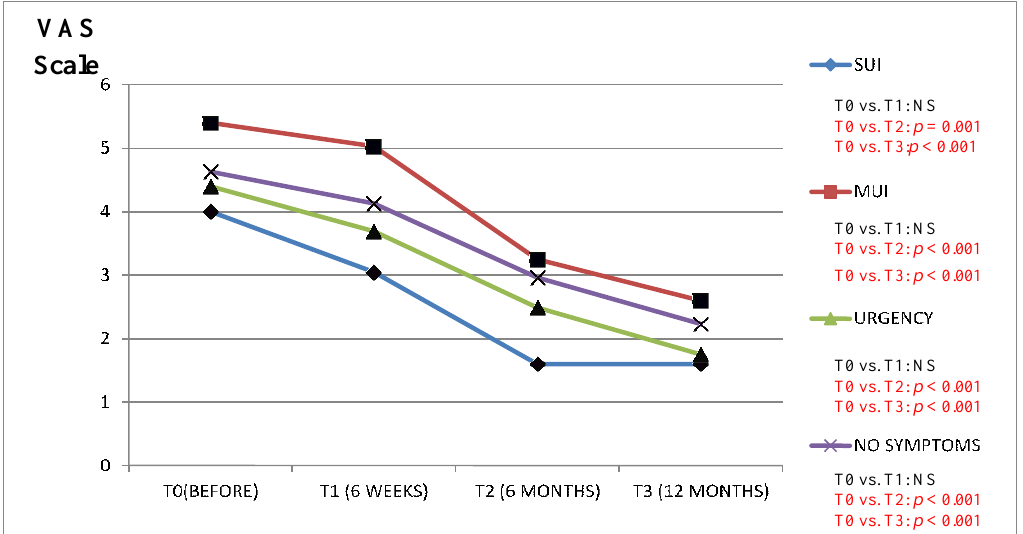
Figure 5. Impact of the vaginal native tissue repair (VNTR) on sexual life—according to the visual analogue scale (VAS).